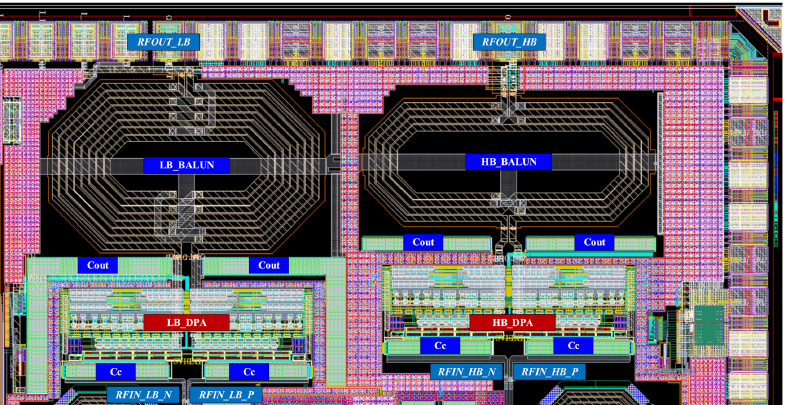
Figure 5. The top layout of the dual-band